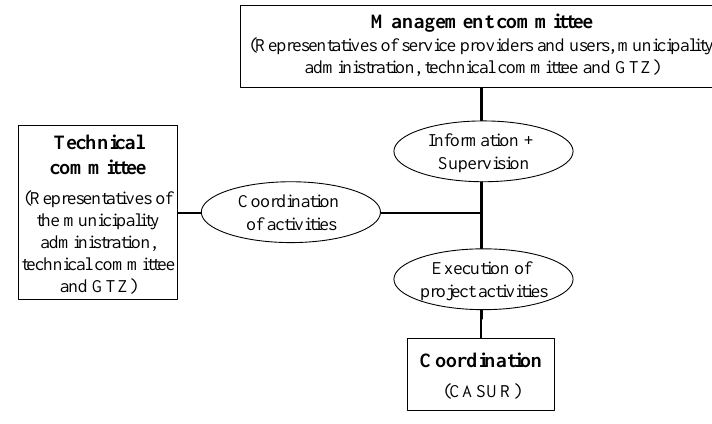
Fig. 2. Institutional framework supporting the payment scheme.